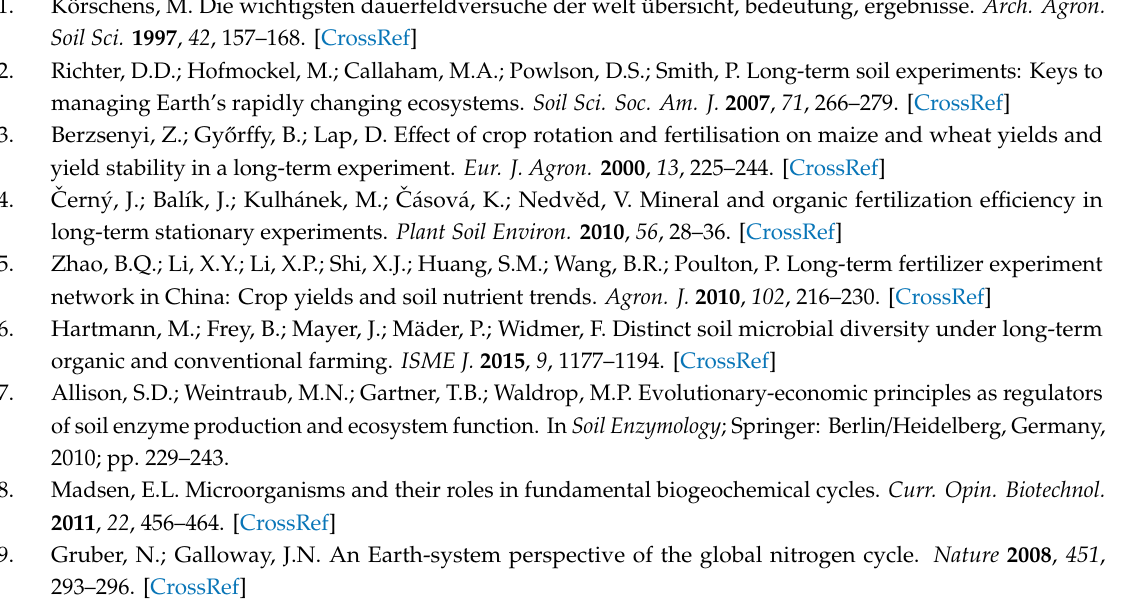
s1, Figure S1: UPGMA tree of beta-diversity distances, Figure S2: Beta-diversity plot of the soil bacterial microbiota, calculated at OTU 97 level, in the two soil habitats, under the four N-fertilization treatments, Figure S3: OTUs significantly a ff ected by fertilization treatment in the bulk soil, Table S1: Details of the fertilization treatments, Table S2: Thermal profiles and primers used for